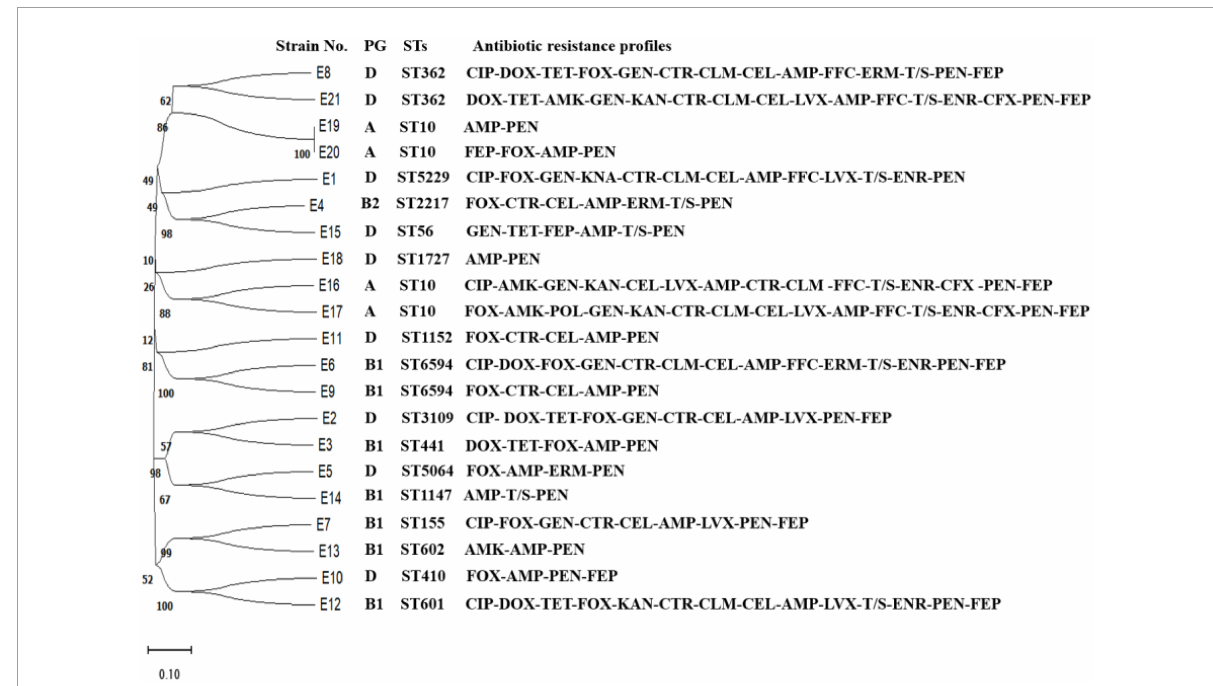
FIGURE2 Evolutionary tree of ST types and drug resistance profile in diarrheagenic calves source Escherichia coli